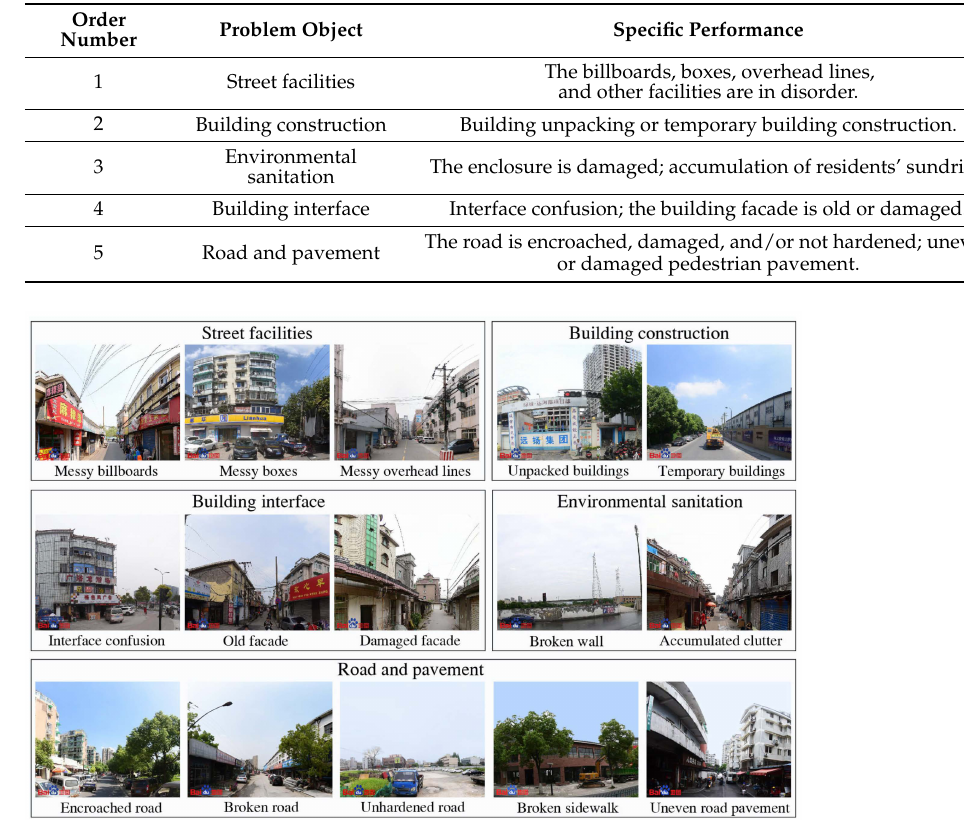
Figure 7. Schematic diagram of street spatial quality